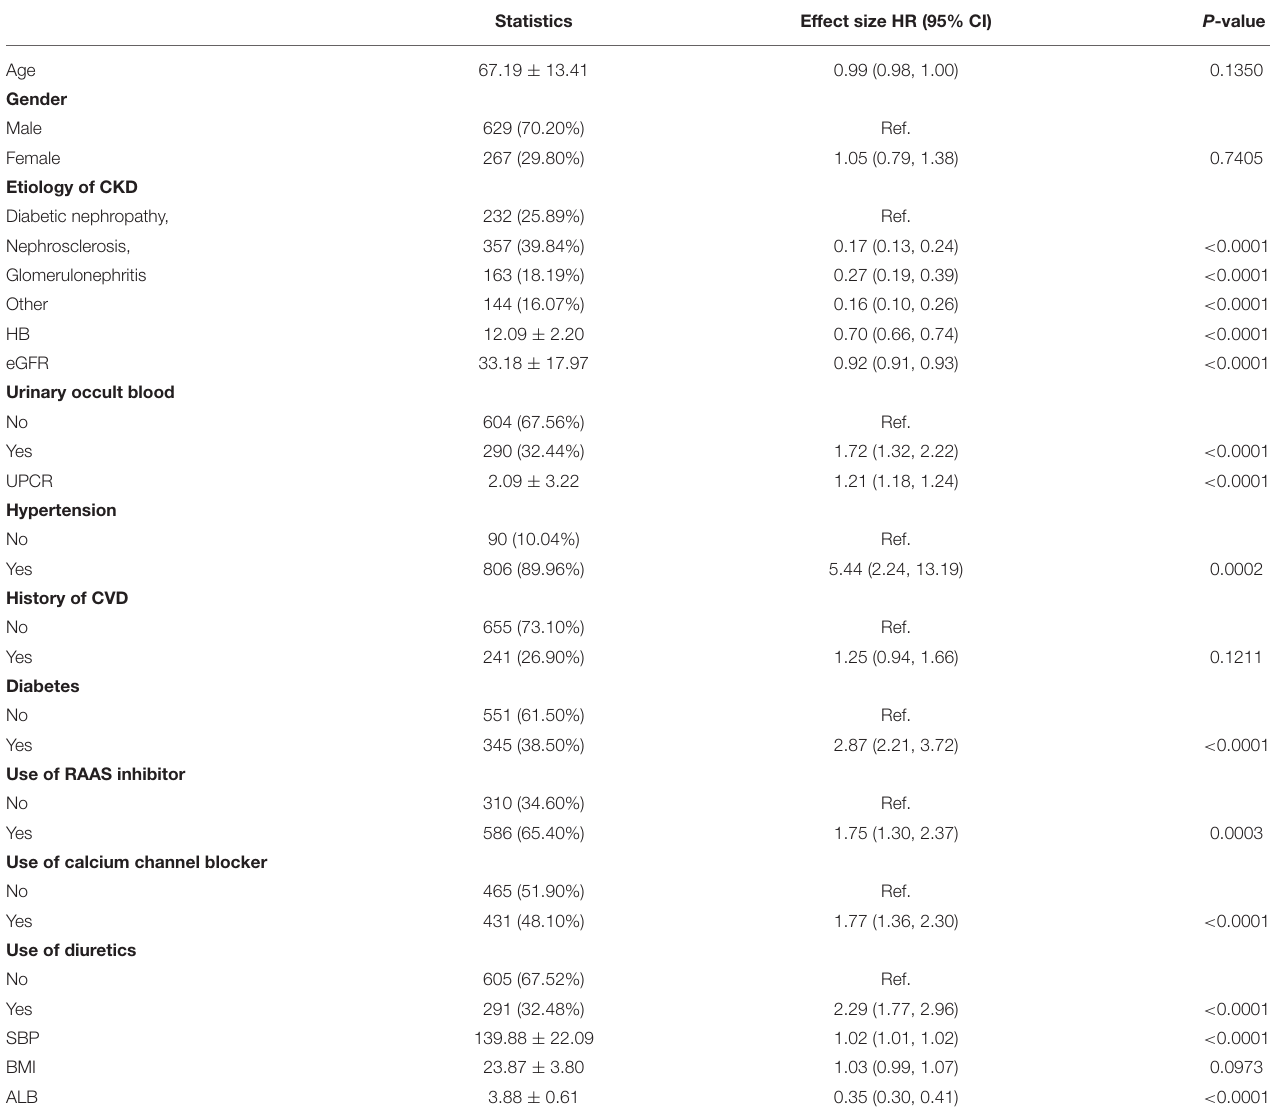
TABLE 3 | The results of univariate